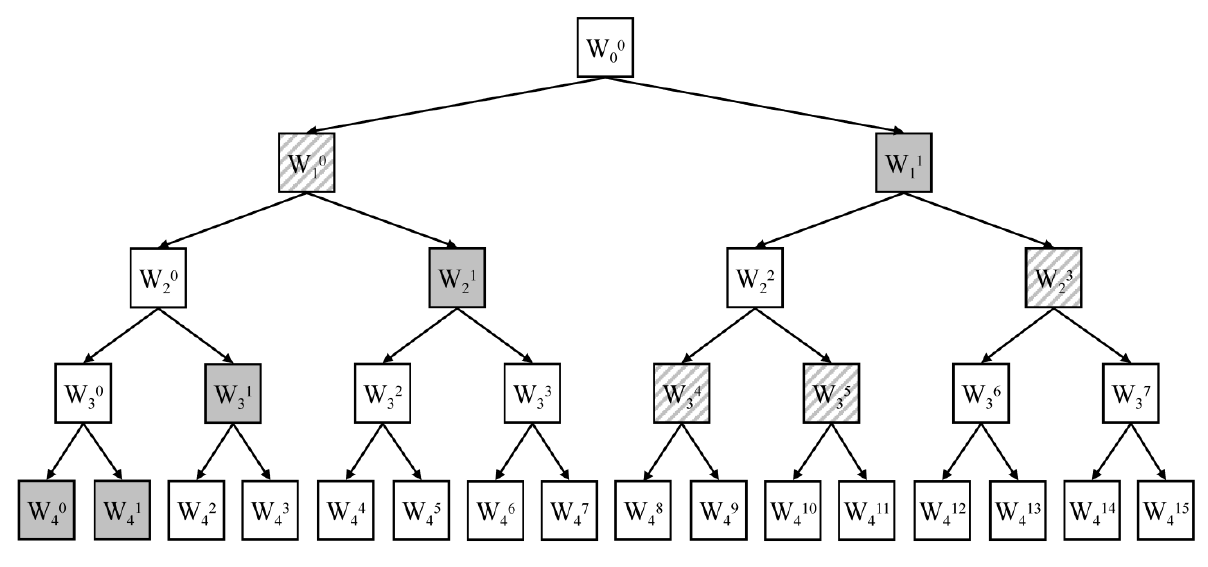
Figure 4. Library of wavelet packet functions. Different subspaces are represented by W ij . Index ‗i‘ is the scale index, index ‗j‘ is the frequency index. The depth ‗I‘ of this tree is equal to 4. Every subtree within this tree, where each node has either 0 or 2 children, is called an admissible tree. Two admissible trees are emphasized, one shaded in grey and one marked with